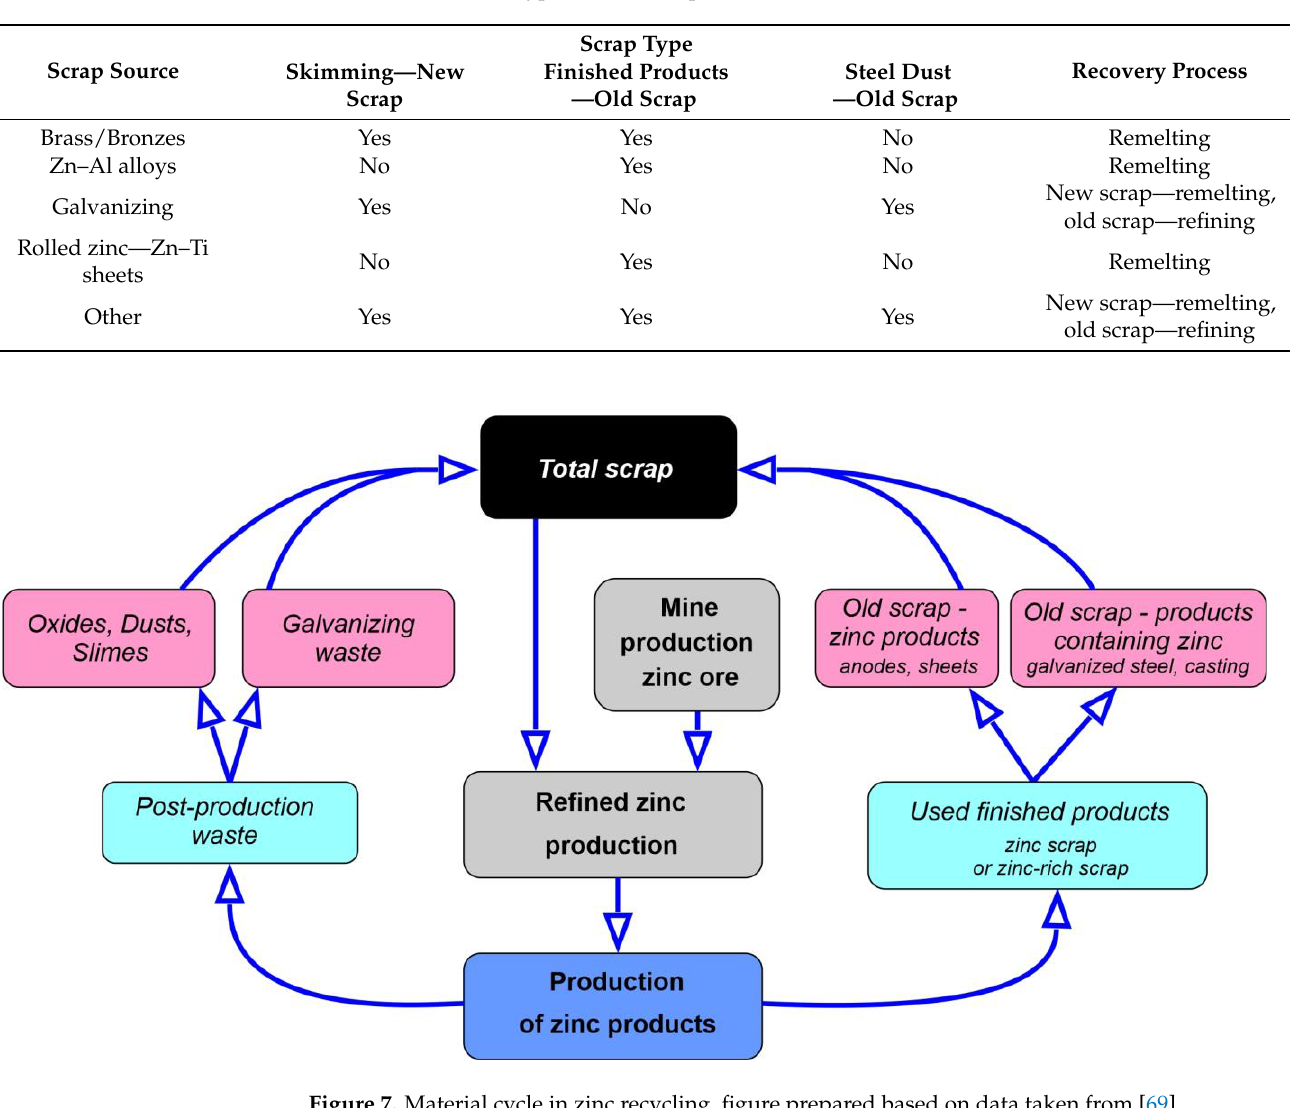
Table 6. Sources and types of zinc scrap, worked out based on [68].